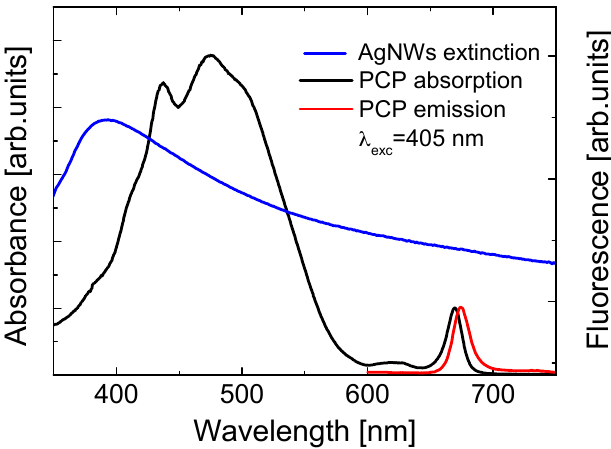
Figure 1. Absorption and emission spectra of Peridinin–Chlorophyll–Protein (PCP) (black and red lines, respectively) and extinction spectrum of AgNWs (blue line).